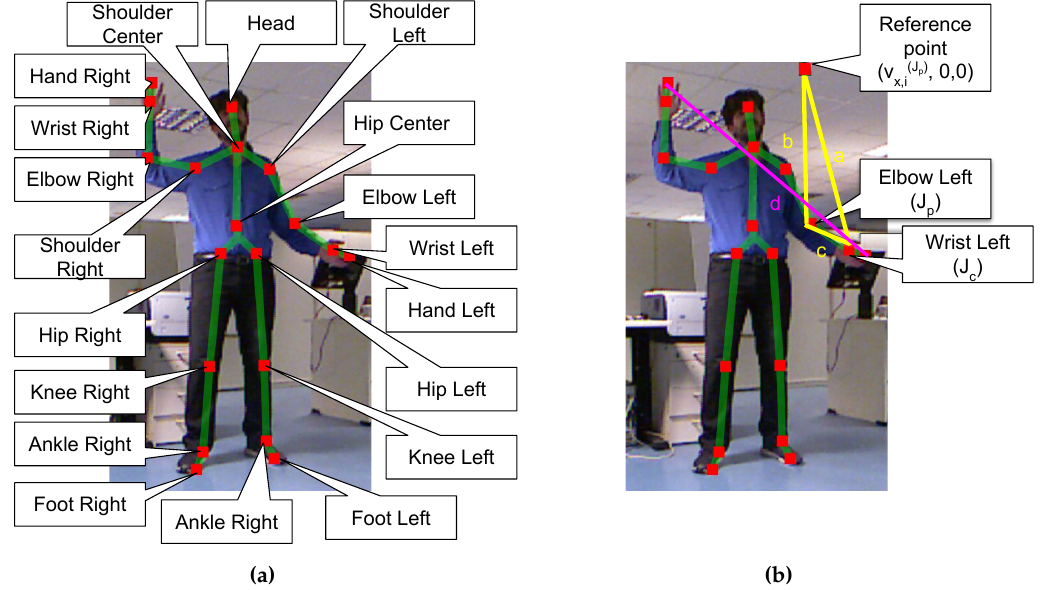
Figure 1. ( a ) Extracted human skeleton 3D joints using the Kinect software development kit (SDK). ( b ) Visual representation of a given node J , its parent J p and its child J c ; a , b , c , d , used in Equations (2)–(6) J p and the reference point ( v ,0,0 ) x , i